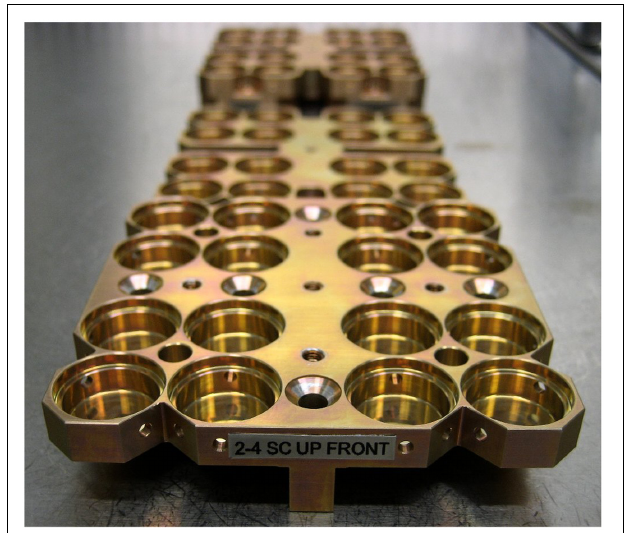
FIGURE 3 | Design of 16-well sample carriers 2-4 with three layers: top, middle, and bottom, marked up, intermediate, and low. Credit: DLR.